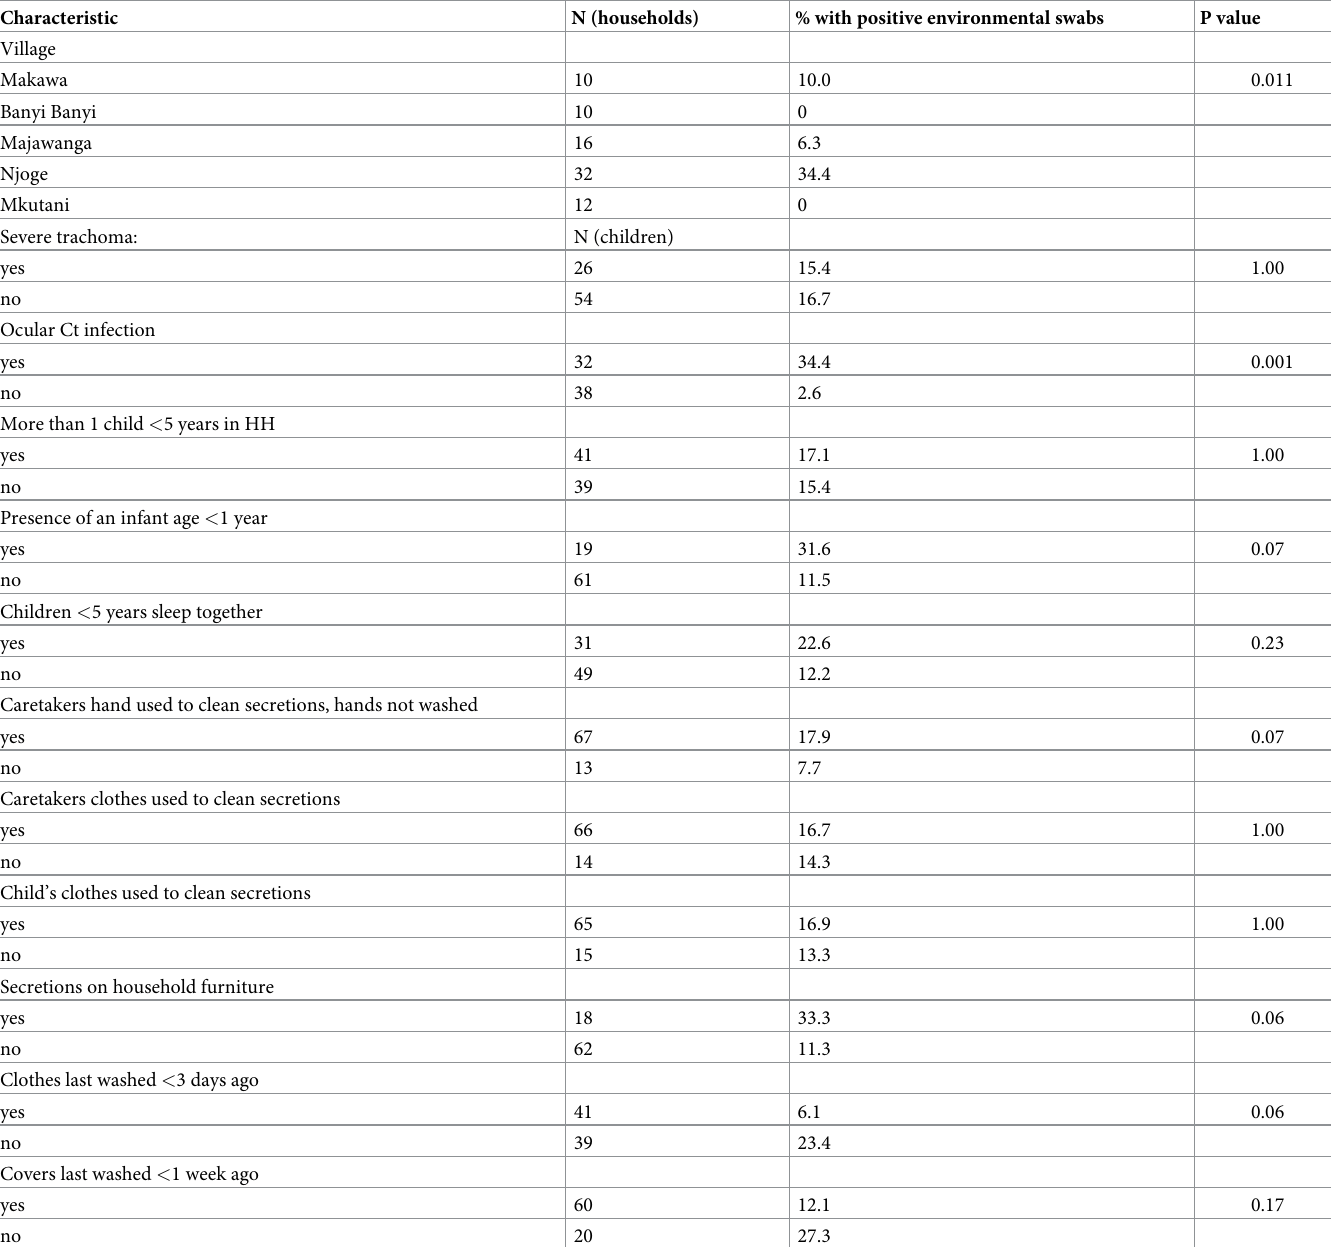
Table 4. Unadjusted associations between positive environmental swabs and household/index child characteristics.